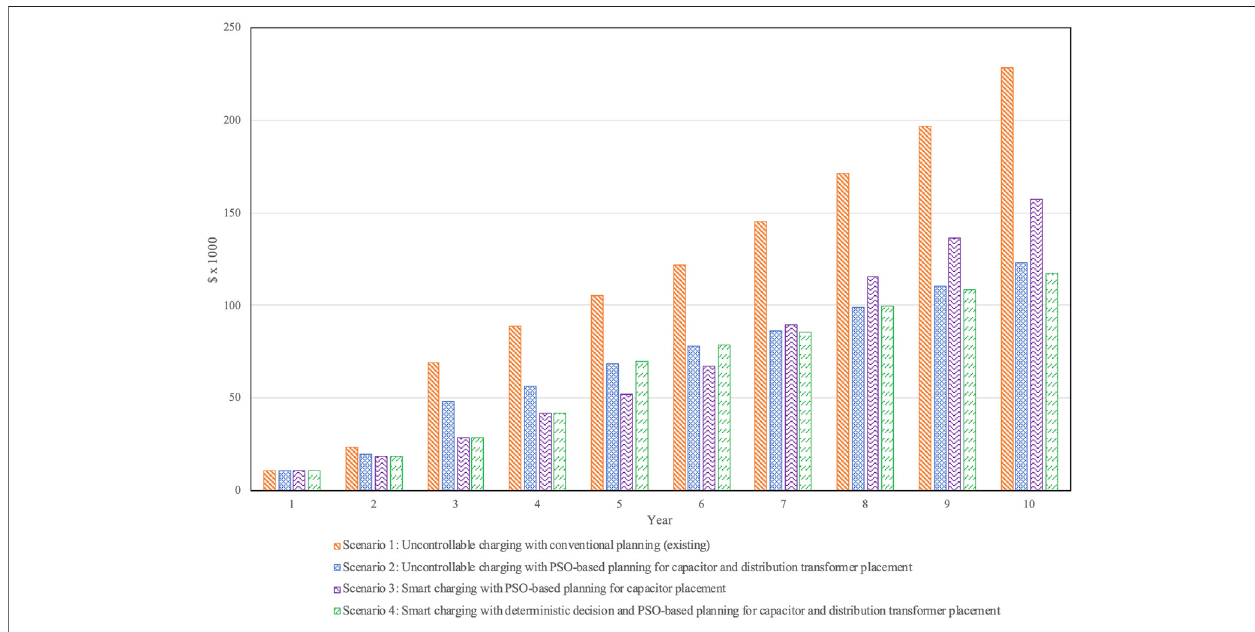
FIGURE 8 | Yearly cumulative total cost in 122 bus low-voltage distribution